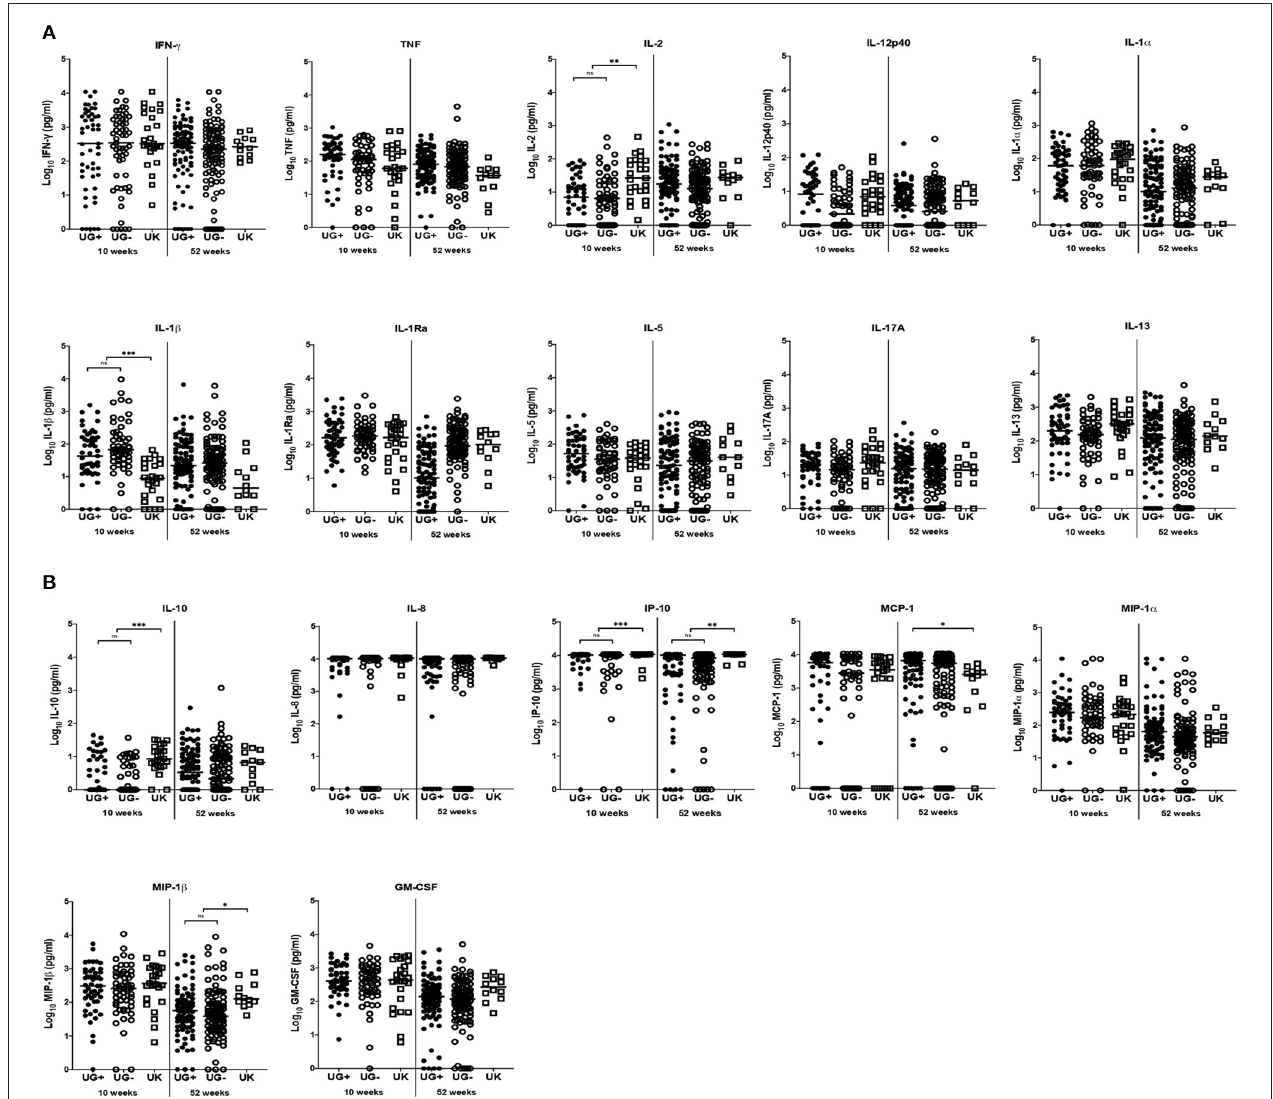
FIGURE 1 | Comparison of immune response to PPD in infants from Uganda and United Kingdom. (A) Median IFN- γ , TNF, IL-2, IL-12p40, IL-1 α , IL-1 β , IL-1Ra, IL-17A, IL-5, and IL-13 production following 6-day stimulation of whole blood with PPD in infant samples obtained at 10 and 52 weeks after BCG immunization. These are presented on the log scale in pg/ml. Closed and open circles represent Ugandan infants of mothers with (UG + ) and without (UG–) LTBI, respectively. Open squares represent infants in the UK. The asterisk (*) represents ** p < 0.001, *** p < 0.0001. ns, not statistically significant. (B) Median IL-10, IL-8, IP-10, MCP-1, MIP-1 α , MIP-1 β and GM-CSF production following 6-day stimulation of whole blood with PPD in infant samples obtained at 10 and 52 weeks after BCG immunization. These are presented on the log scale in pg/ml. Closed and open circles represent Ugandan infants of mothers with (UG + ) and without (UG–) LTBI, respectively. Open squares represent infants in the UK. The asterisk (*) represents ** p < 0.001, *** p < 0.0001. ns, not statistically